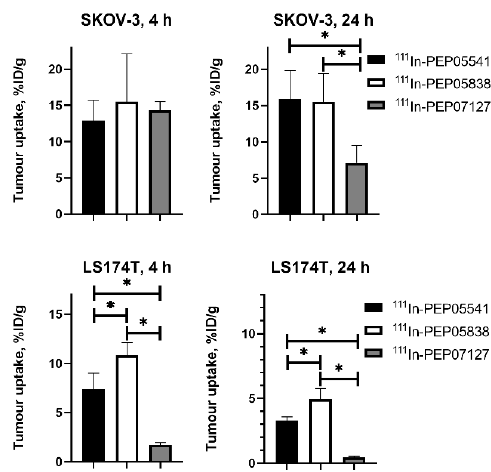
Figure 4. Influence of the affinity of affibody molecules on the accumulation in tumor xenografts with high (SKOV-3) and low (LS174T) human epidermal growth factor receptor type 2 (HER2) expression at different time points. Asterisk (*) indicates significant ( p < 0.05) difference. Data are taken from [63].